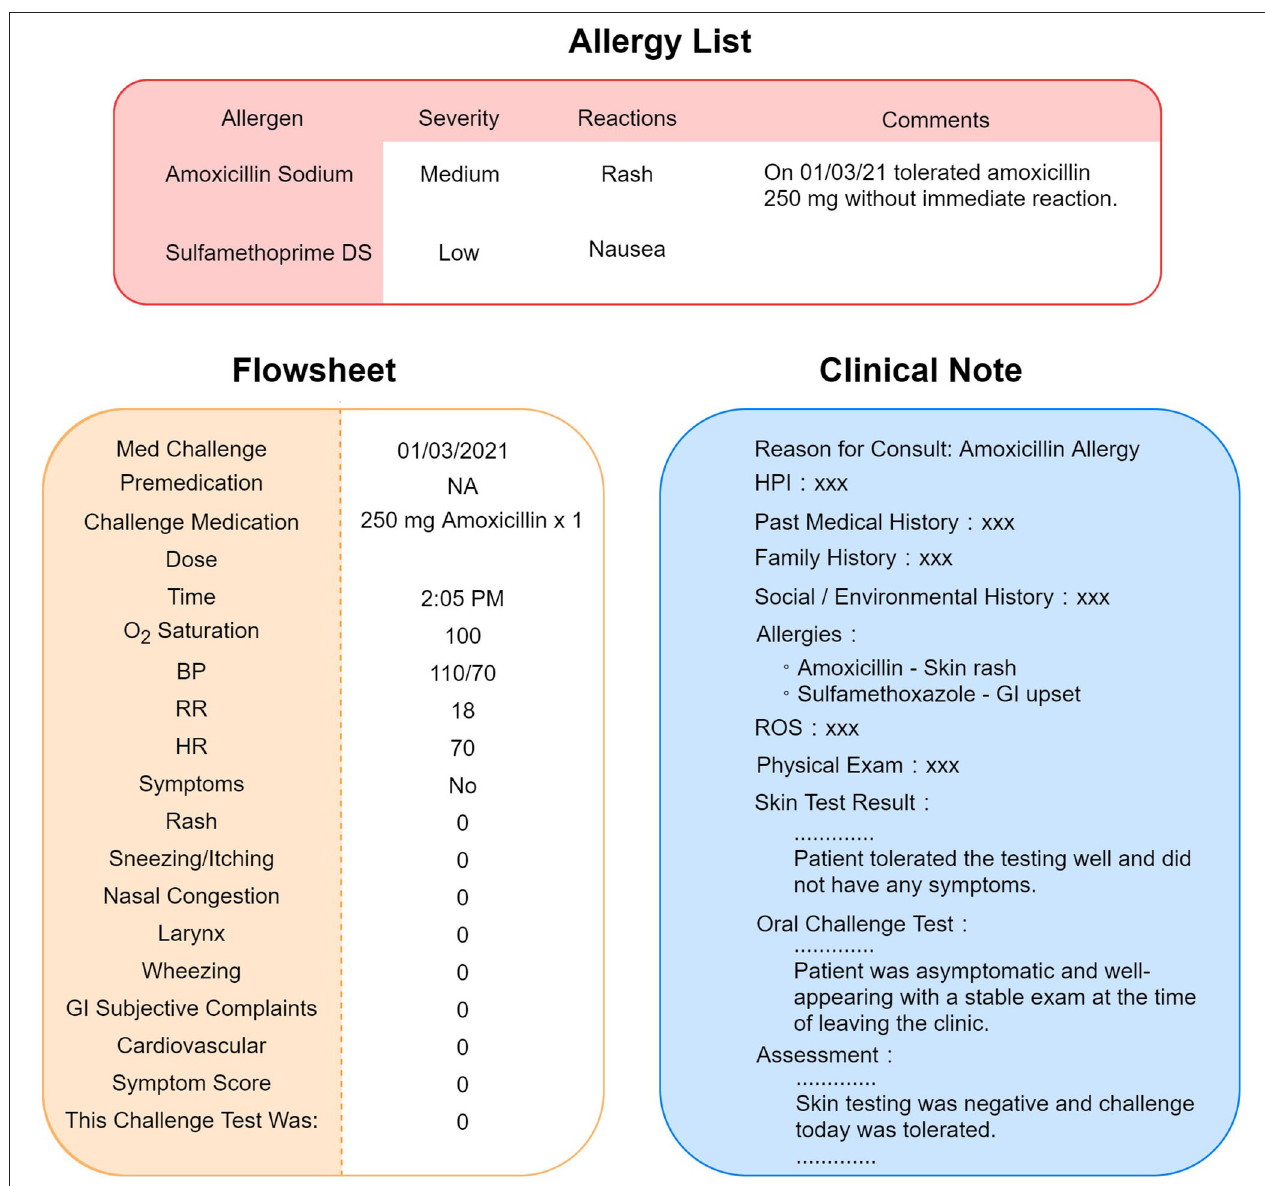
FIGURE 1 | Scenario of allergy information discrepancy in EHR. Allergy list, flowsheets, and clinical notes are different locations in the EHR that store allergy information. A negative result of drug challenge test may not be updated to the allergy list accordingly. Sometimes, the physician would leave a comment instead of removing the allergen from the list, as pictured in this